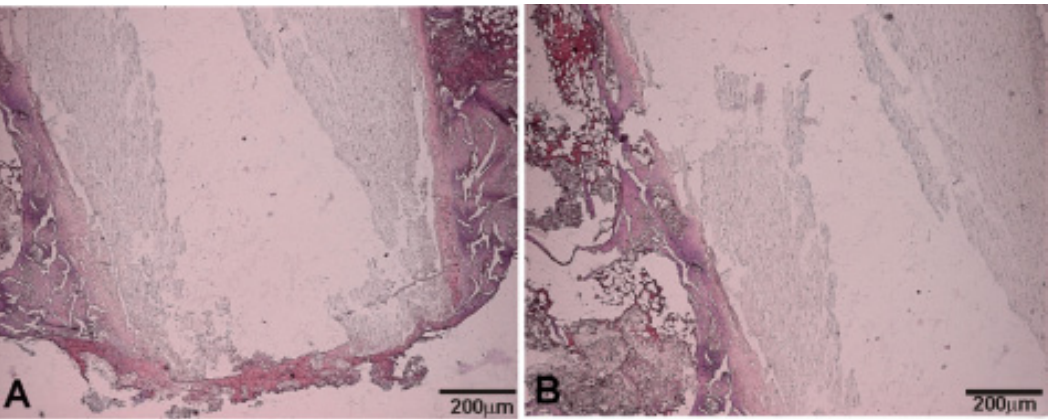
Figure 3. Haematoxylin-eosin stained cross-sections of the implant after four months of implantation. ( A ) Lower part of the implant; ( B ) Middle part of the